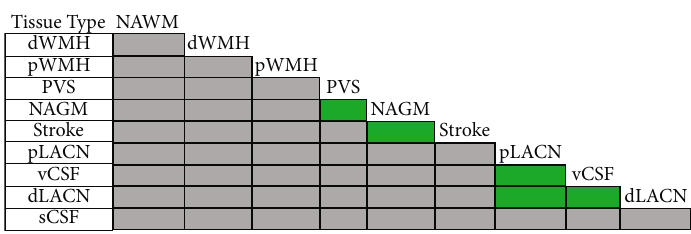
Figure 5: Di ff erences in the FA and MD values measured by the DTI processing pipeline between the tissue types considered in this study. Cells shaded with gray indicate signi fi cant di ff erence ( p value < 0.05) between both FA and MD values in the two related tissue types. Cells shaded with green indicate signi fi cant di ff erences ( p value < 0.05) in MD but not FA between tissue types. All the pairwise comparisons were adjusted for age, sex, and education level.